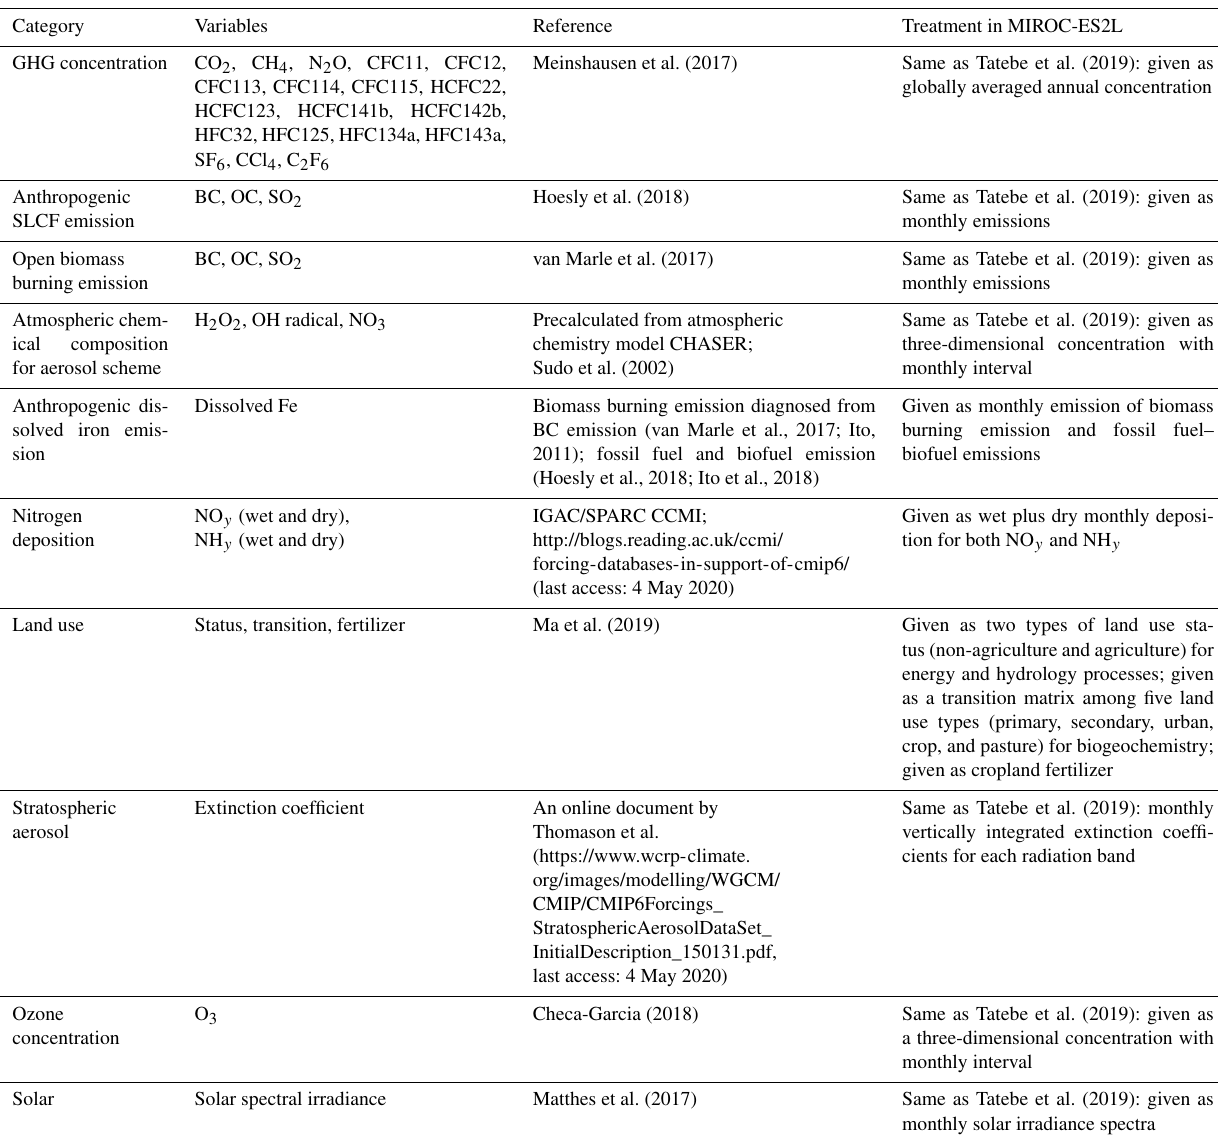
Table C1. List of forcing datasets for the HIST simulation: categories, variables, and references for the data creation and a description of how the datasets are applied in the HIST simulation in